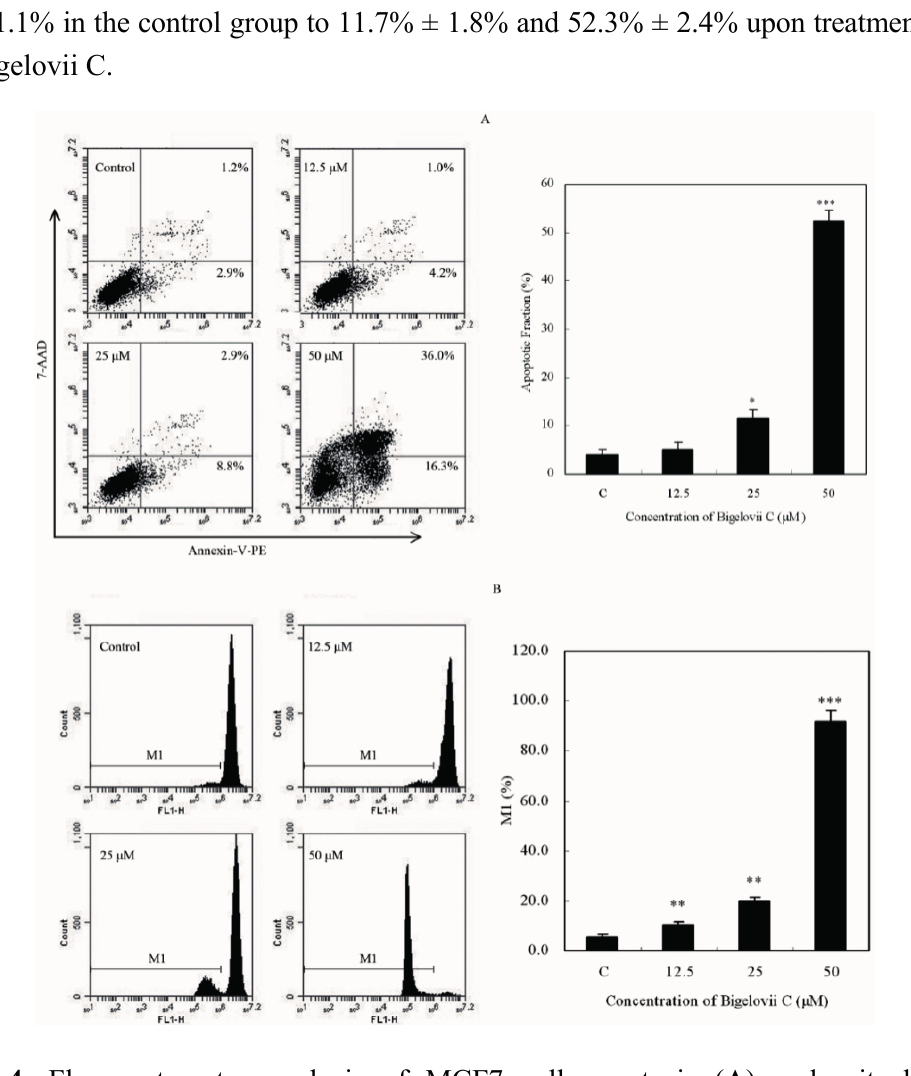
Figure 4. Flow cytometry analysis of MCF7 cell apoptosis ( A ) and mitochondrial membrane potential ( B ). * p < 0.05, ** p < 0.01 and *** p < 0.001, compared with the control